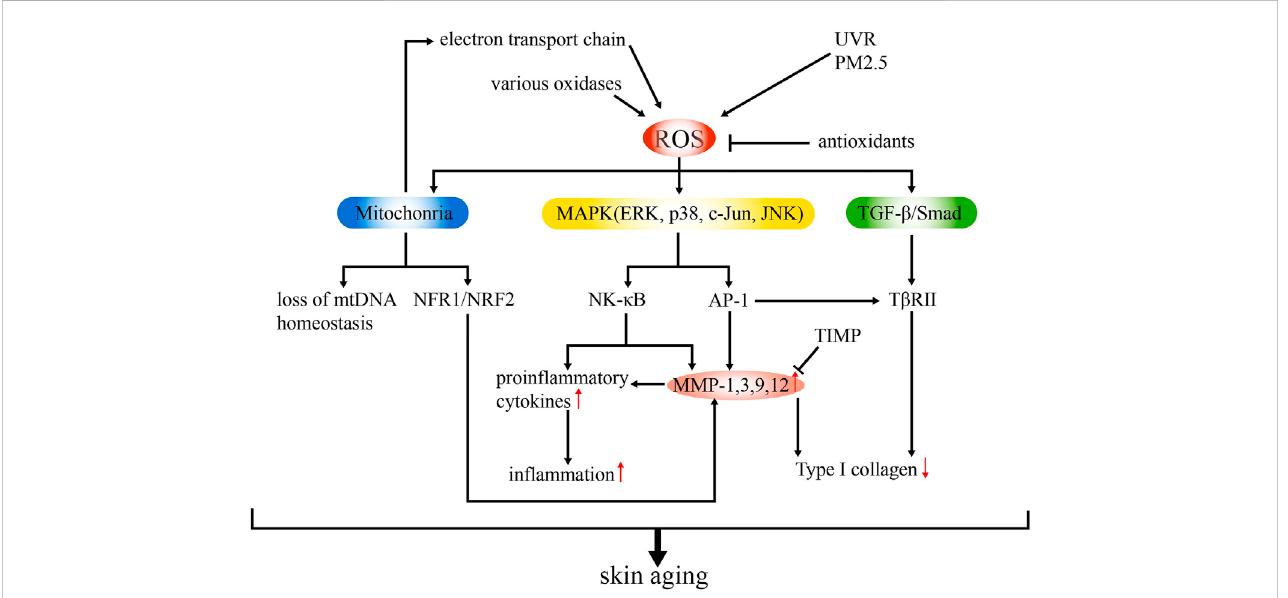
FIGURE 1 SchematicmodelofthemechanismsofROS-relatedskinaging.ROSaregeneratedfromvariousintrinsic(eg.,electrontransportchain,variousoxidases) and extrinsic sources (e.g., UVR, PM2.5). Overproduction of ROS can lead to upregulated MMP expression and in fl ammation and suppressed collagen synthesis via mitochondrial dysfunction and activation of MAPK and TGF- β signaling pathways. Antioxidants and TIMP can ameliorate ROS production, thus delaying skin